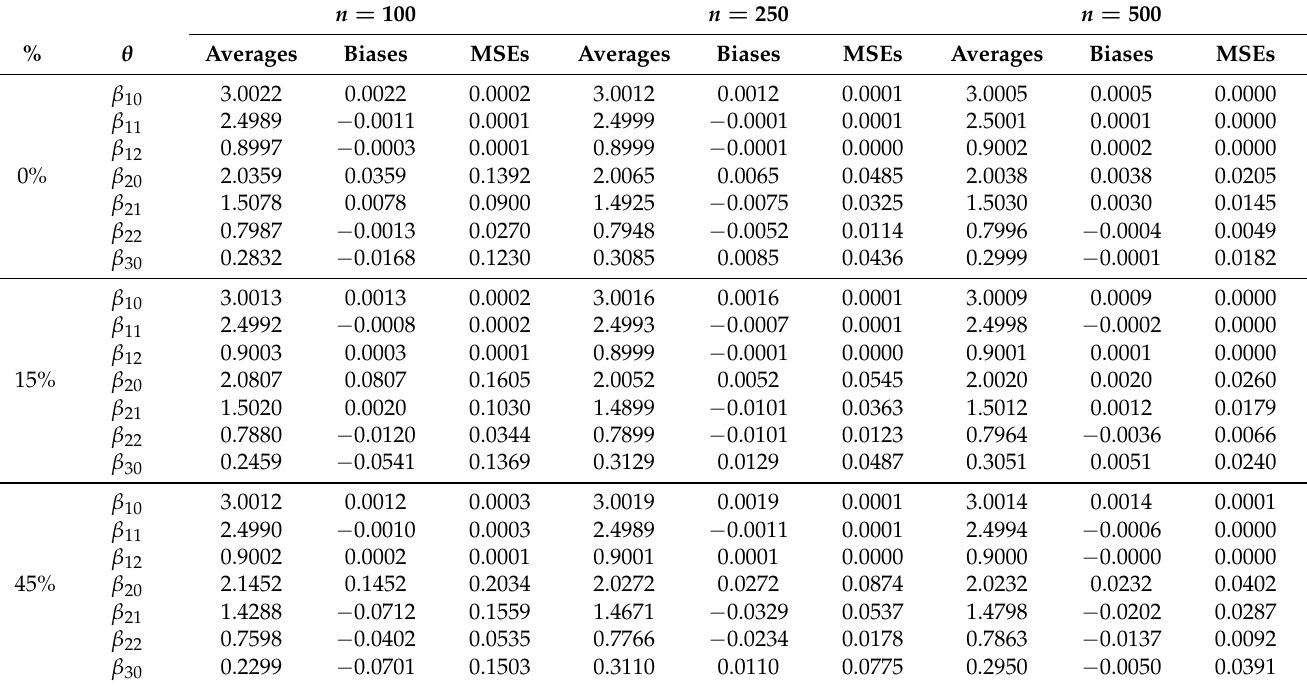
Table 1 reveals that the (Averages) estimates tended to the true parameters and their biases and mean square errors (MSEs) decayed to zero when n became large. So, the consis- tency of the estimators holds. We also checked the model through the empirical coverage probabilities (CPs) of the 95% confidence intervals of the estimates. Table 2 shows that the CPs were close to the nominal level. Figure 2 proves that the empirical distribution of the deviance residuals approximated the standard normal. So, the normal probability plot can be used with simulated envelopes. Table 1. Findings for the averages, biases, and MSEs from the simulated OLLW regression model.